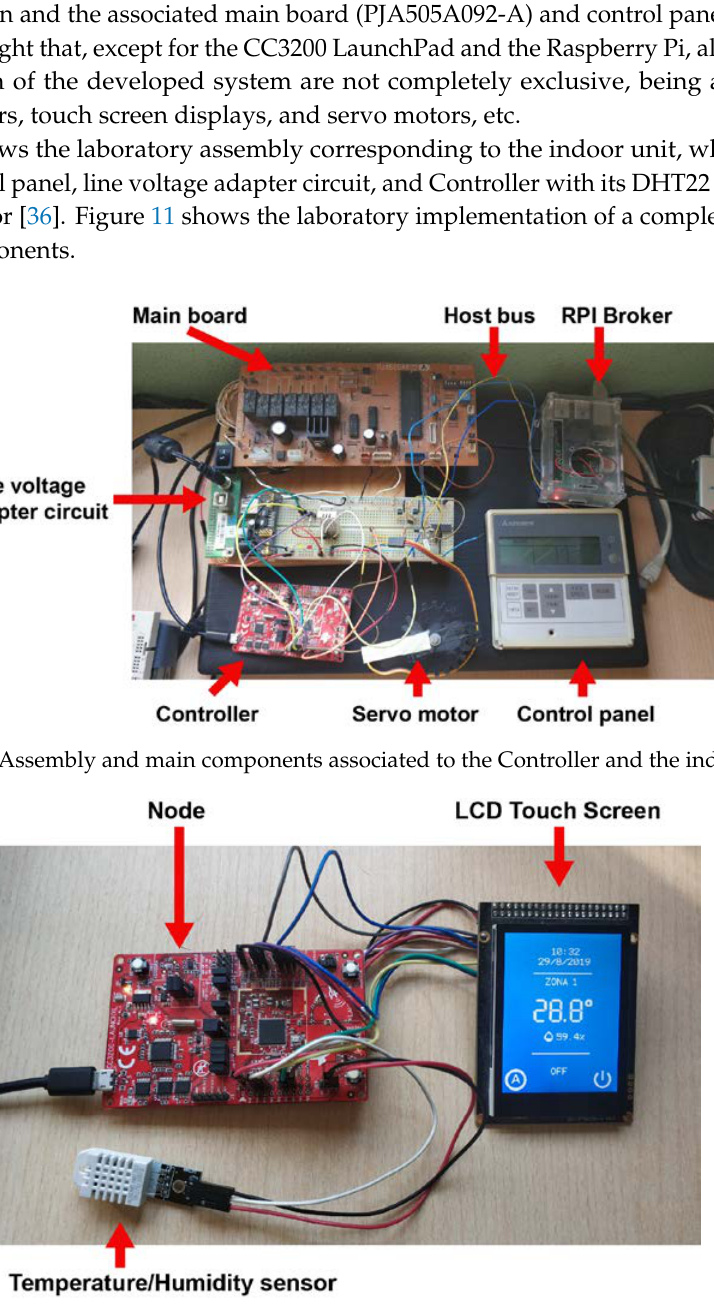
Figure 11. Assembly and main components associated to the Node.